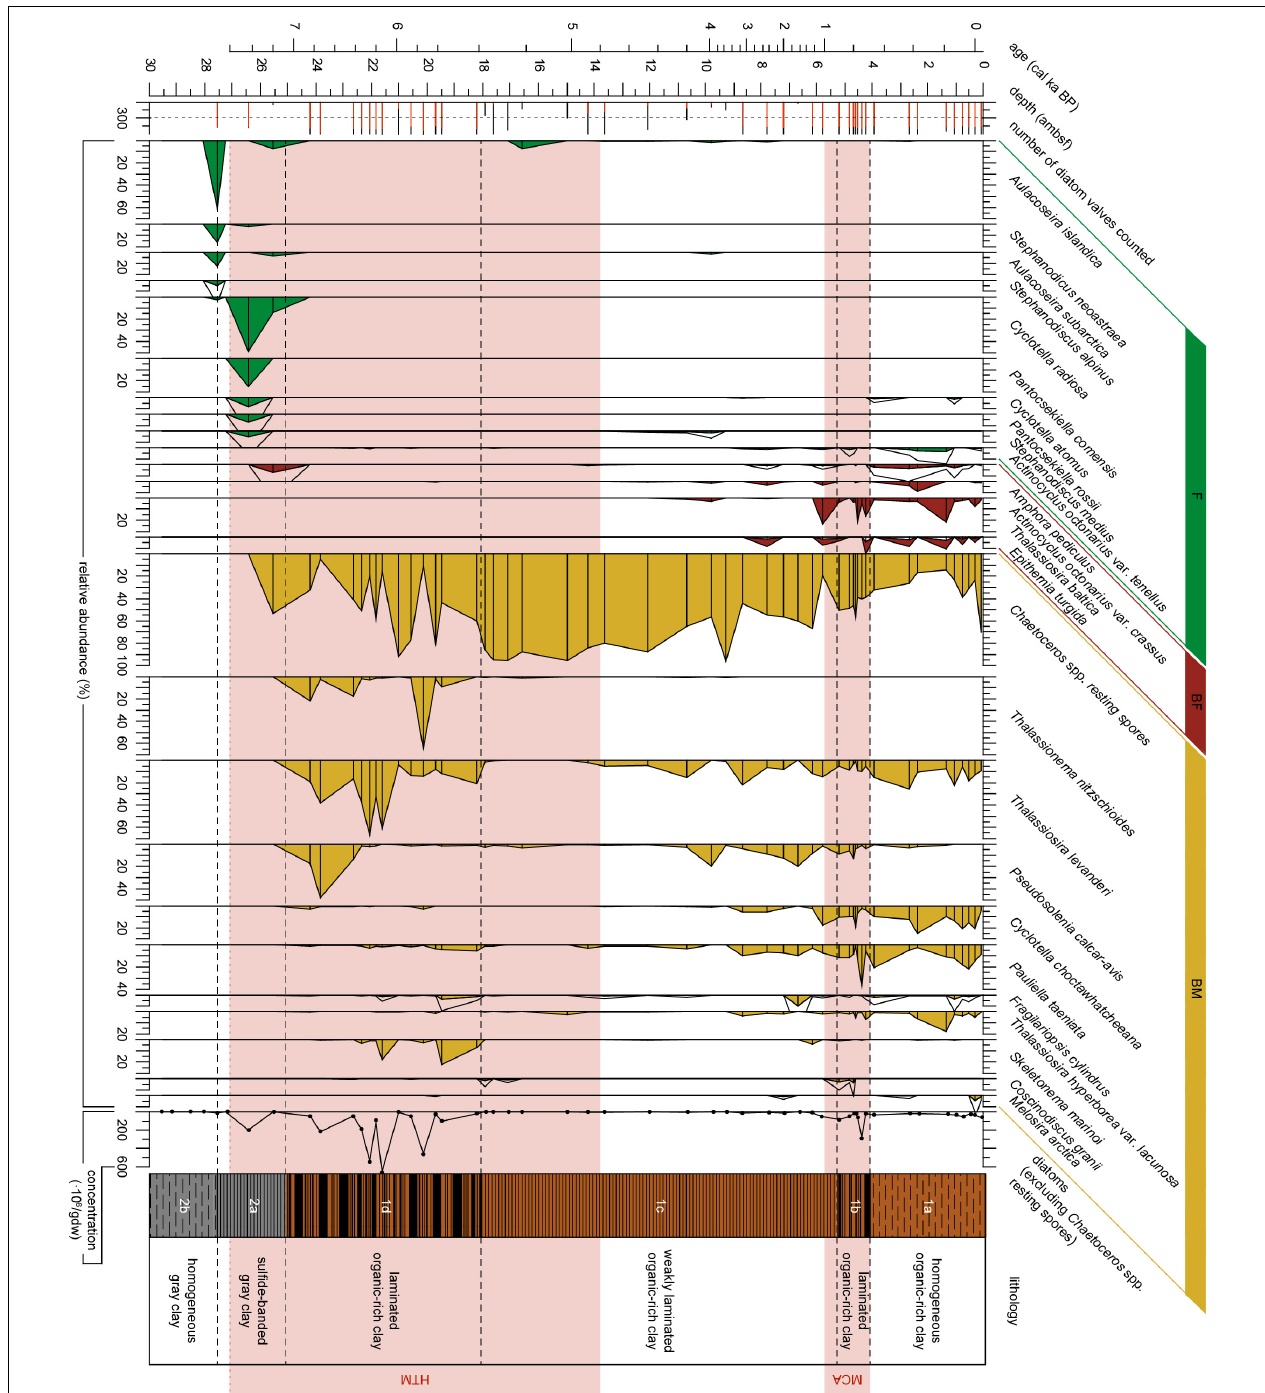
FIGURE 3 | Diatom stratigraphy for the upper ∼ 27 ambsf (adjusted meters below seafloor) of Integrated Ocean Drilling Program Expedition 347 core M0063D. The number of diatoms counted are indicated in red for diatom valves other than Chaetoceros spp. resting spores, the black bars indicate the number of Chaetoceros spp. resting spores counted, the dotted vertical line represents a count of 300. Relative abundances (%) of diatom taxa with an abundance of 4% or greater in any sample versus depth (ambsf) are plotted as filled areas, for diatom species with a relative abundance < 10% a 4x exaggeration is added by the black line. Analyzed levels are indicated by black bars. Diatoms are arranged by their environmental preference with respect to salinity (F, Freshwater affinity; BF, Brackish-Freshwater affinity; BM, Brackish-Marine affinity), and by their first occurrence. Absolute abundance of vegetative diatom valves in millions of valves per gram dry weight (gdw). The warm climate anomalies Holocene Thermal Maximum (HTM, 8–4.8 cal ka BP, Seppä et al., 2009) and Medieval Climate Anomaly [MCA, 1.0 - 0.7 cal ka BP(MCA, 1.0 – 0.7 cal ka BP, Mann et al., 2009)] are represented by the light red areas. Lithology and sedimentological units are obtained from Andrén et al. (2015).